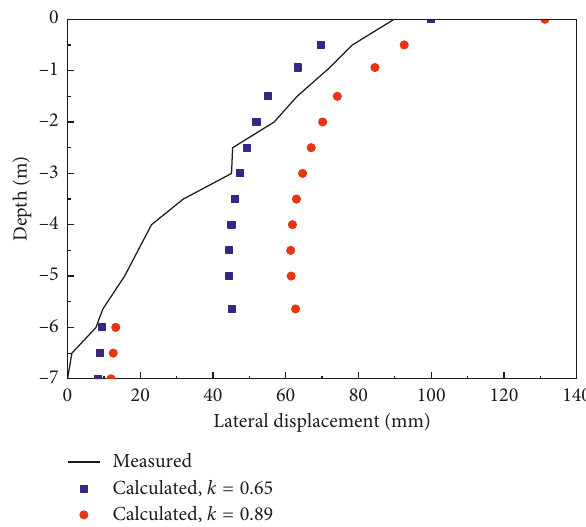
Figure 7: Lateral strain factor variations.